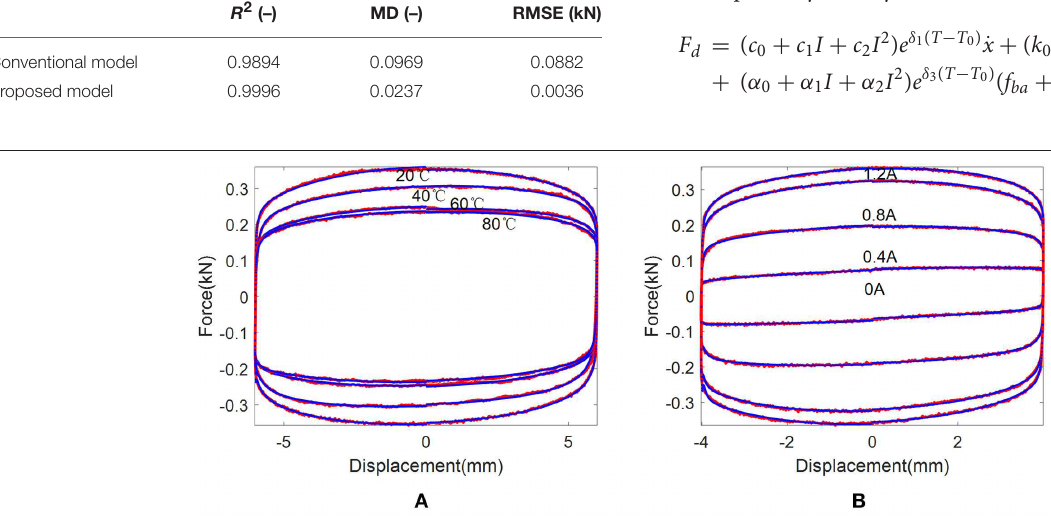
Frontiers in Materials |